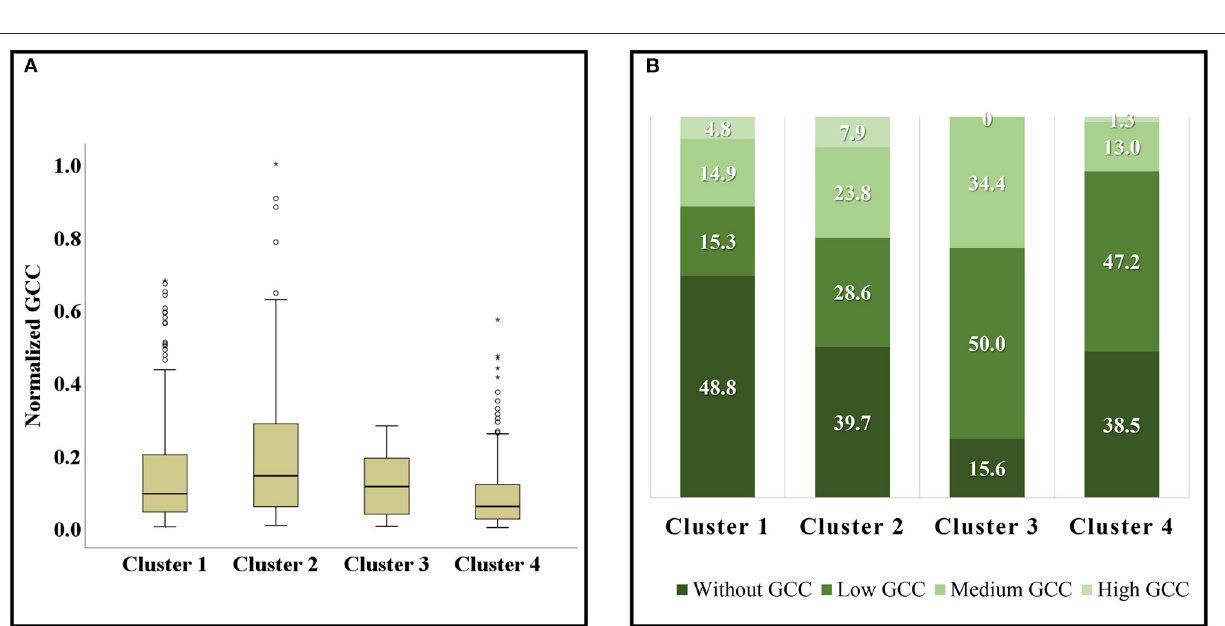
FIGURE 10 | The box diagram of GCC distribution in different clusters (A) , the proportion of green spaces with different levels of GCC in different clusters (B) . Hollow circles ◦ represent mild outliers; asterisks * represent extreme outliers. distance, the change of the effect becomes lower and